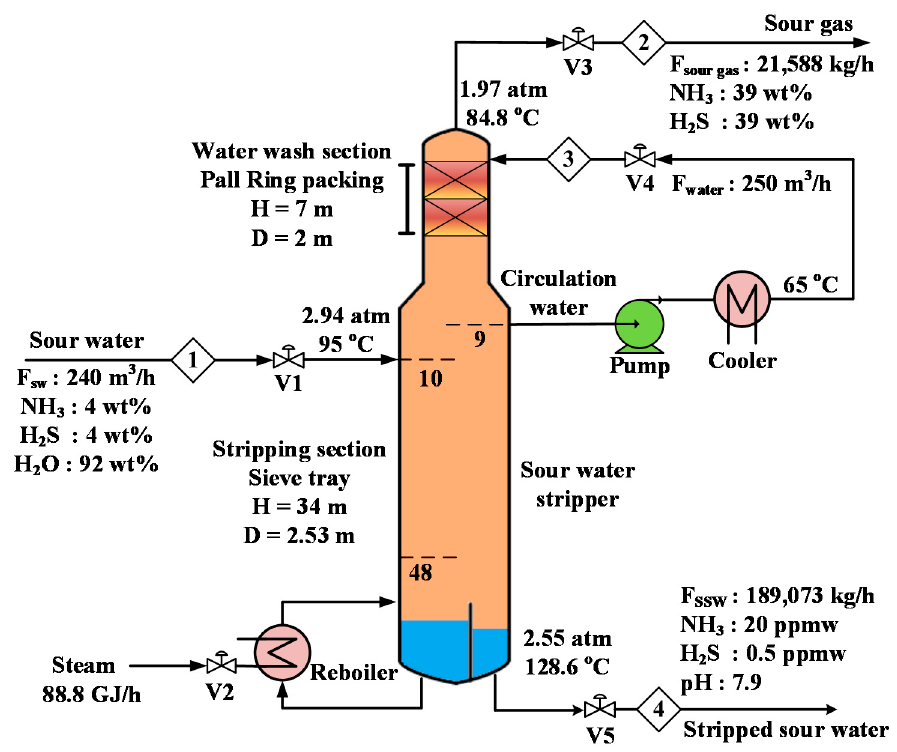
Figure 1. A sour water stripper with column specifications and base case operation conditions.